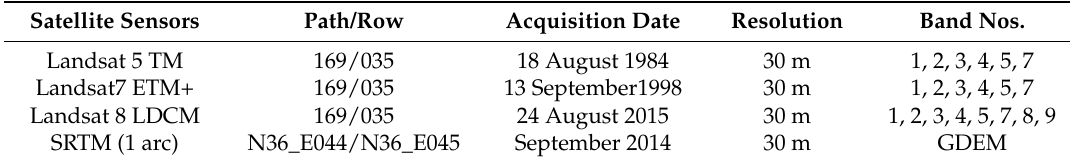
Table 1. Satellite (sub-scene) images used in this study to quantify landscape patterns and land cover changes.